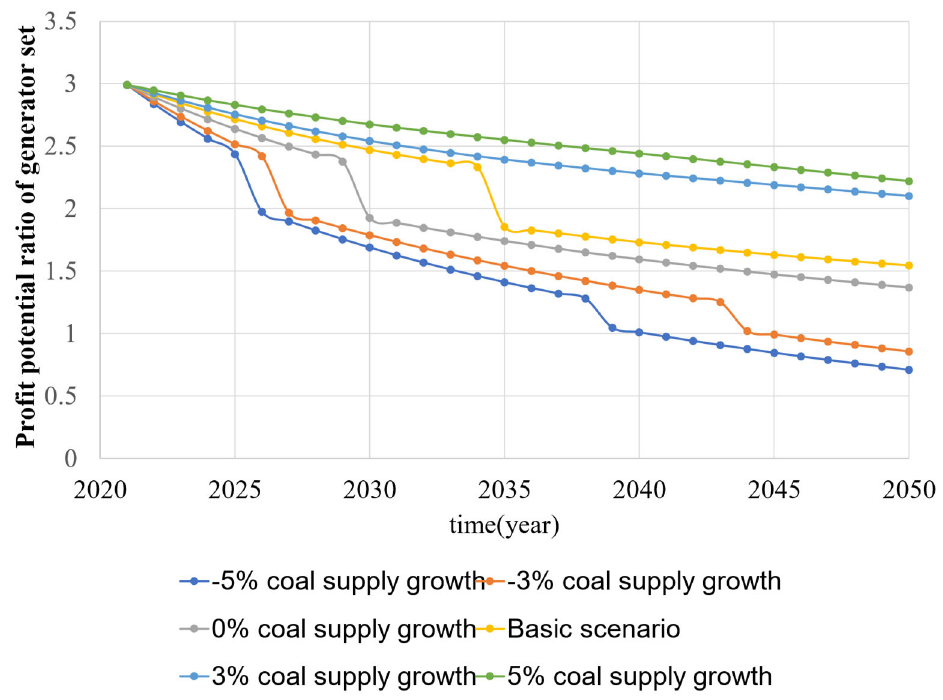
Figure 10. Change in profit potential ratio of thermal power units based on coal supply growth rate.